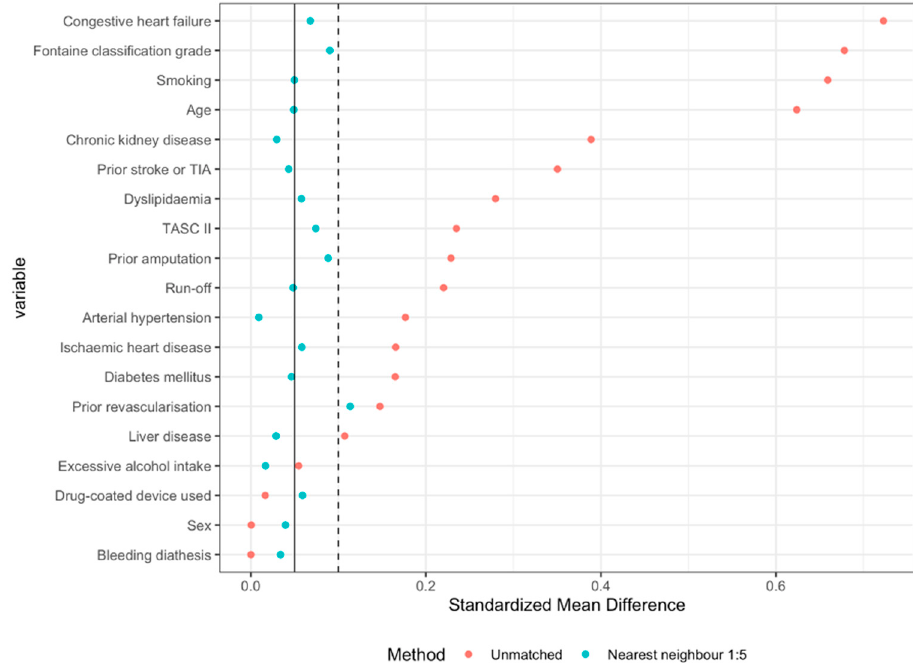
Figure 2. Graphic presentation of the dispersion of standardised mean difference (SMD) values for the group of patients treated with full-dose anticoagulant therapy and the group of patients treated with antiplatelet therapy, before and after matching with the nearest-neighbour 1:5 algorithm with